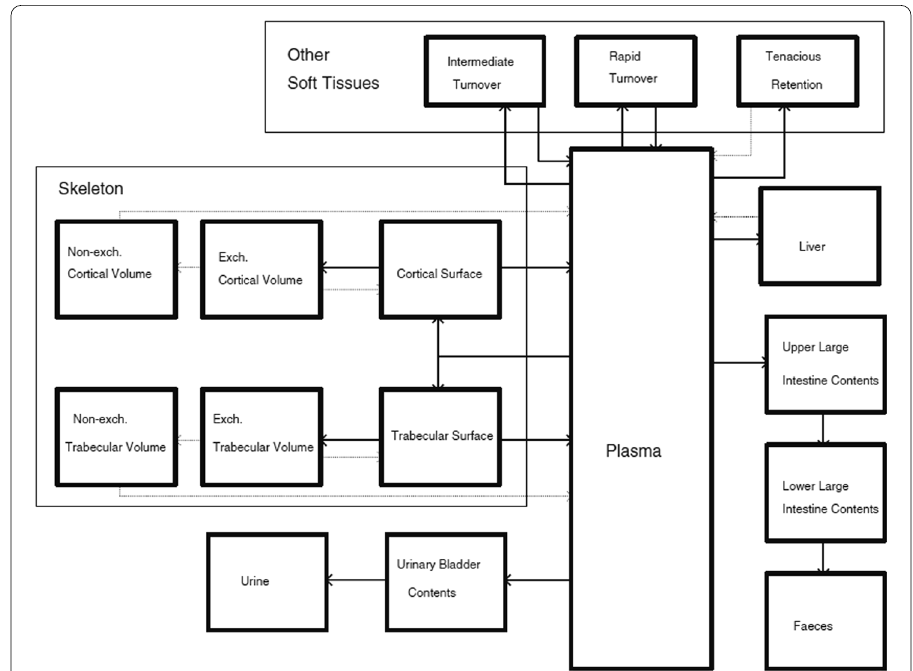
Fig. 4 Biokinetic model for radium as represented in reference [15]. The solid arrows are relevant to the biokinetics of 223